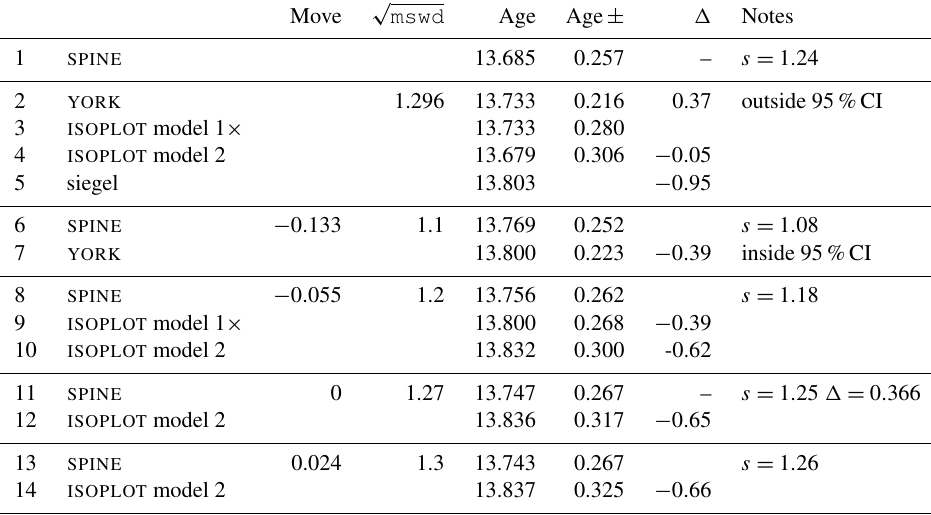
Table A1. Summary of results used in constructing Fig. A1 (see text).